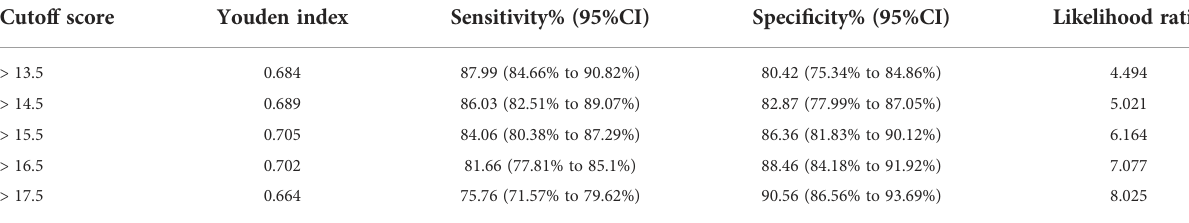
TABLE 4 ROC analysis of the scoring system for identifying APTB in the training set. Cutoff score